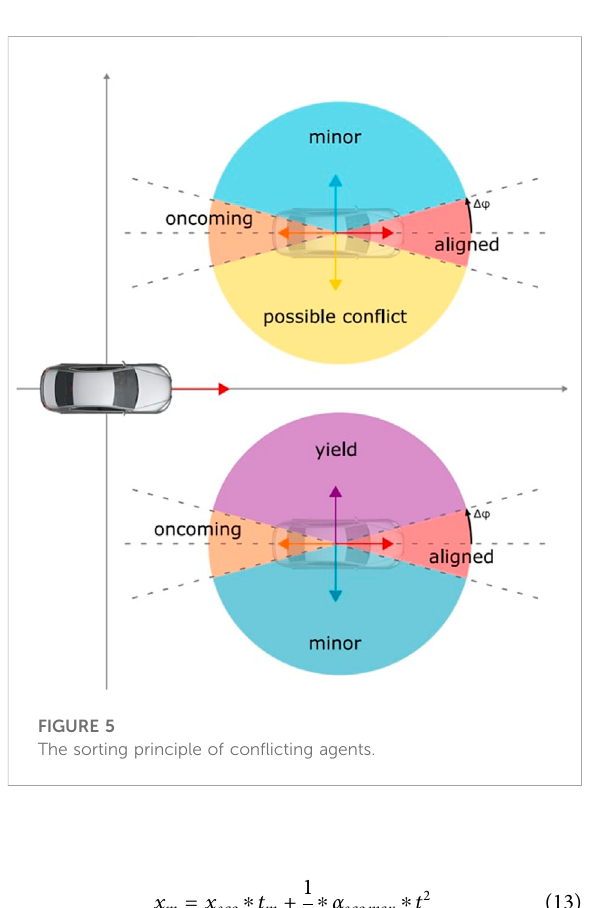
FIGURE 5 The sorting principle of con fl icting